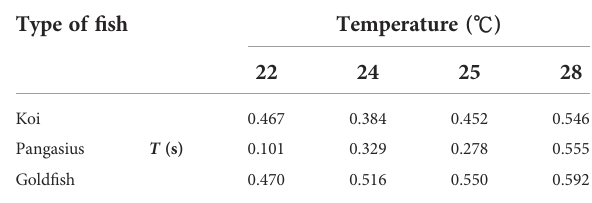
TABLE 4 Integral time scale of the fl ow created by the fi sh schools at the selected water temperatures and at an abundance of 50 animal/m 3 .